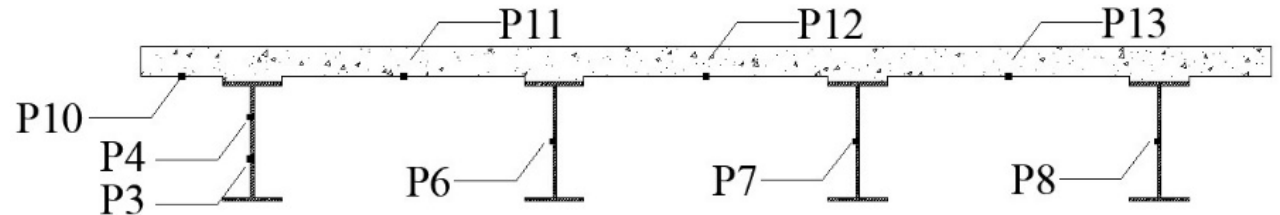
Figure 3. Comparison of wave force histories obtained from the experiments of Istrati [19] and the numerical simulations for SW3 and SW4.